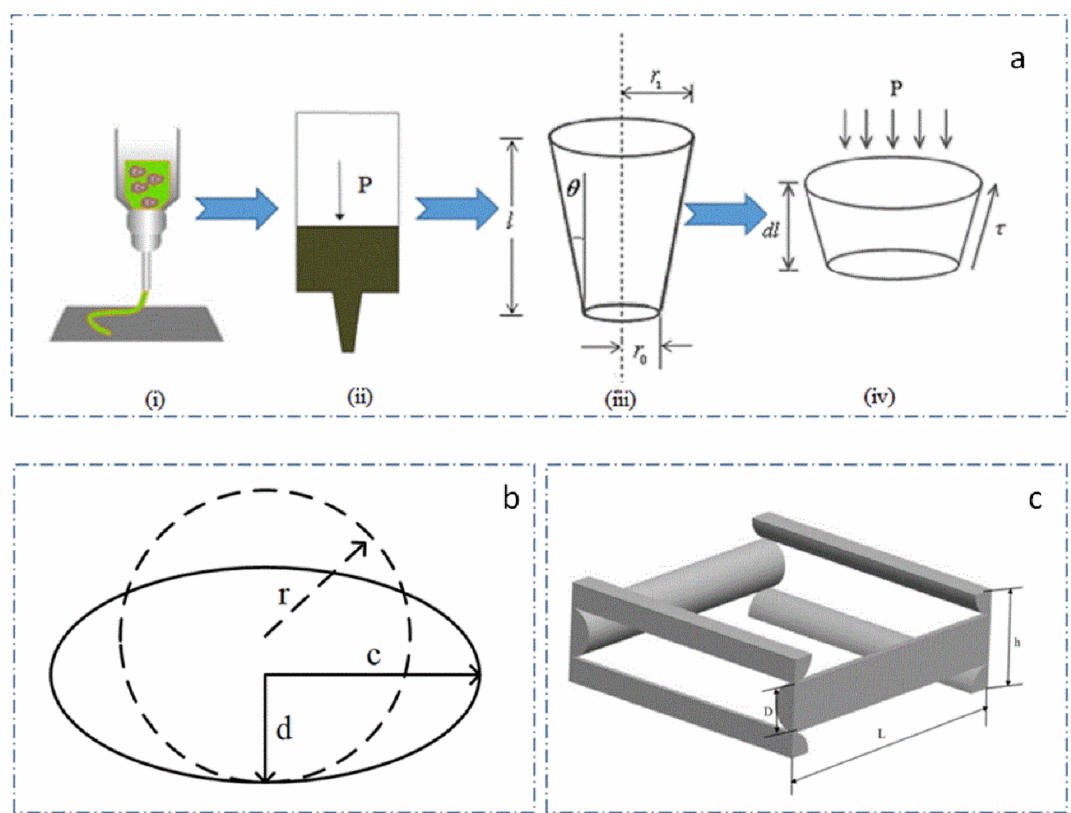
Figure 3. The printing process model and the prediction model of sca ff old porosity. ( a ) simplified model of printhead; ( b ) morphology change of extruded gel; ( c ) unit structure of sca ff